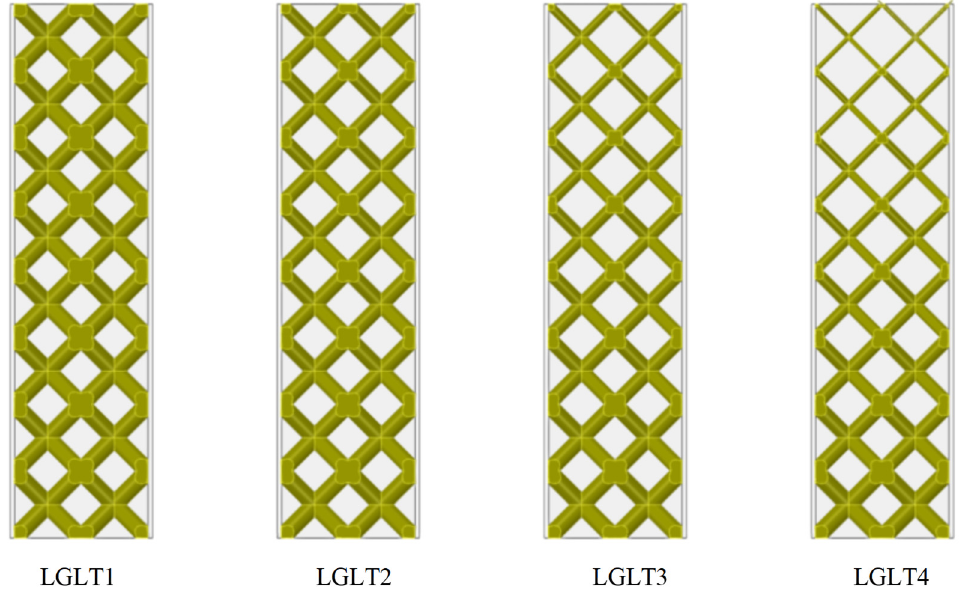
Figure 18. Internal lattice structure model of LGLT hybrid structure with different gradient configurations.